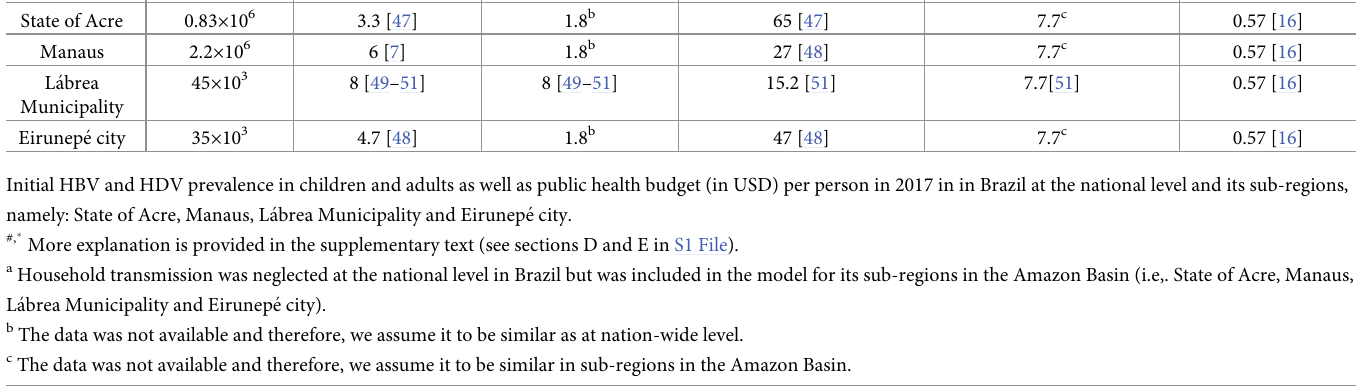
Table 2. Population Stats in Brazil and its sub-regions.